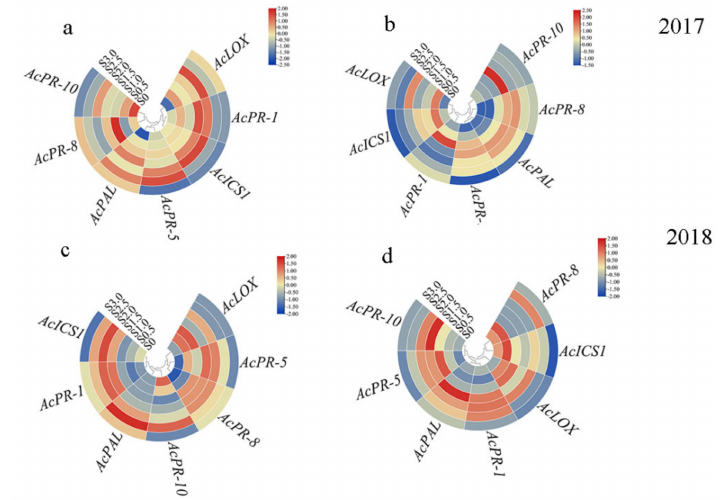
Figure 5. Expression pattern of defense-genes in leaves and stems of kiwifruit treated with sulfur. ( a ) Gene expression of kiwifruit leaves in 2017; ( b ) Gene expression of kiwifruit stem in 2017; ( c ) Gene expression in kiwifruit leaves in 2018; ( d ) Gene expression of kiwifruit stem in 2018. Note: The red and blue circles show up- and downregulated genes. The size of the circle was drawn to show the counts of differentially expressed genes.